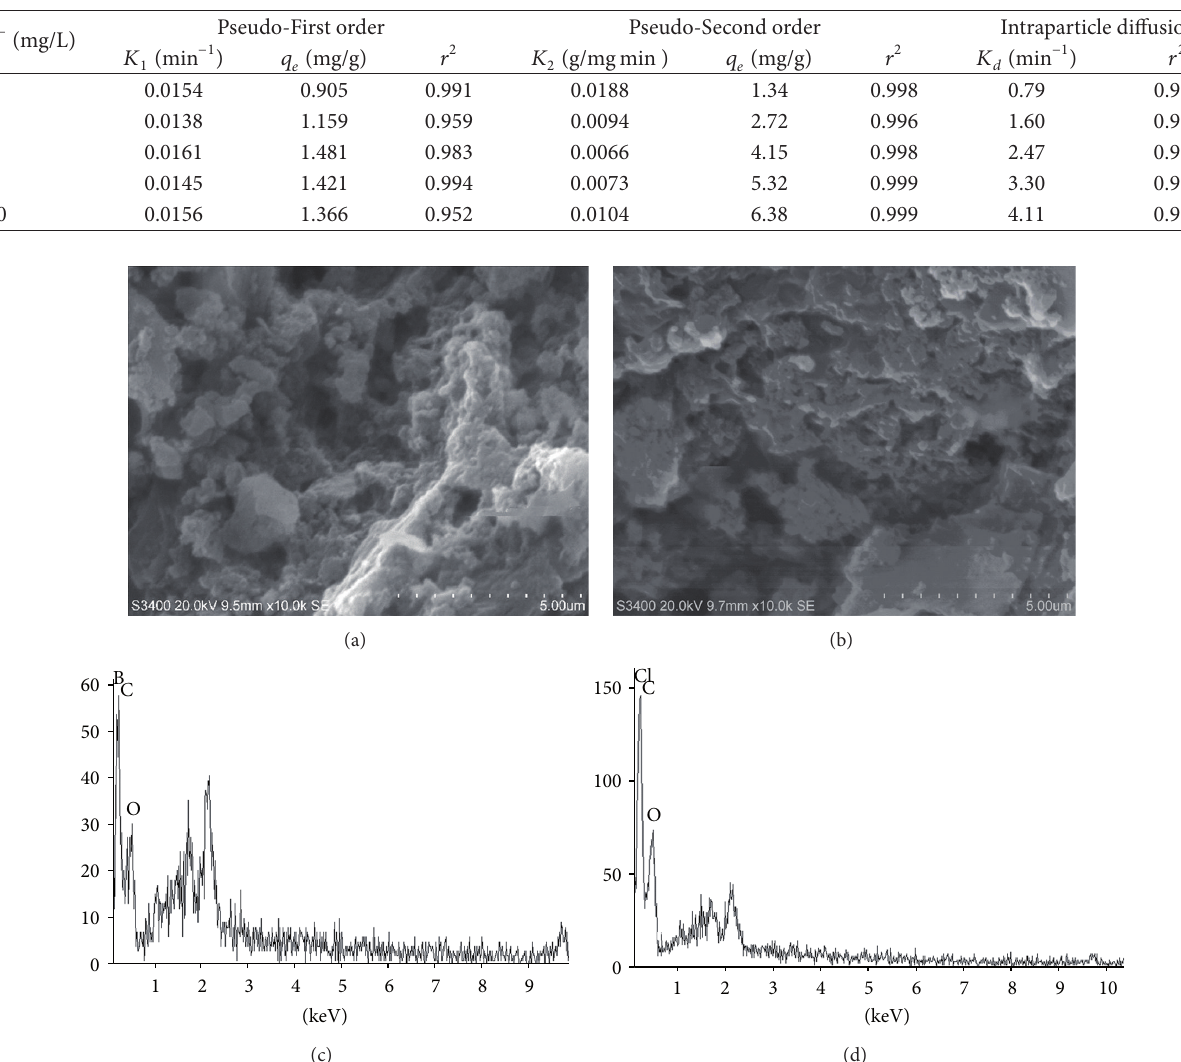
F 3: SEM images of (a) ZIWSC and (b) �uoride-sorbed ZIWSC, and E�A� spectra of (c) ZIWSC and (d) �uoride-sorbed ZIWSC.